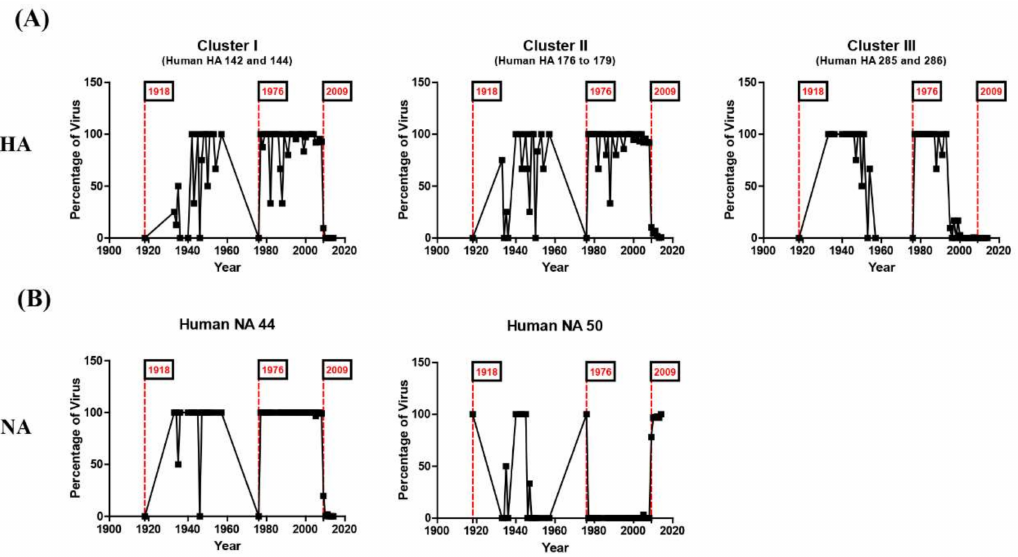
Figure 4. N-linked glycosylation patterns of HA and NA that have distinct differences among pandemic and seasonal H1N1 strains. The glycosylation patterns of HA in ( A ) and NA in ( B ) for human isolates between 1918 and 2015 were analyzed. No glycosylation was observed in all three glycosylation clusters in the 1918 and 2009 pandemics as well as in the 1976 “abortive” pandemic [34], which later turned out to be a local outbreak [15,16]. A gradual increase in glycosylations in cluster II was observed in swine HA in recent years, except for the year 1939, when glycosylations occurred in all three clusters. The NA glycosylations at positions 44 and 50 are mutually exclusive. In human isolates, glycosylation at position 44 was not present for all three (1918, 1976, and 2009)